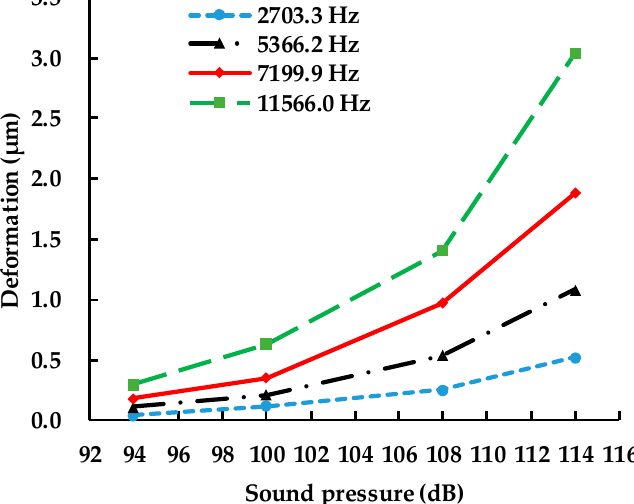
Figure 12. Maximum deformations of MPU6050-Y under acoustic injection of different sound frequencies and pressures.